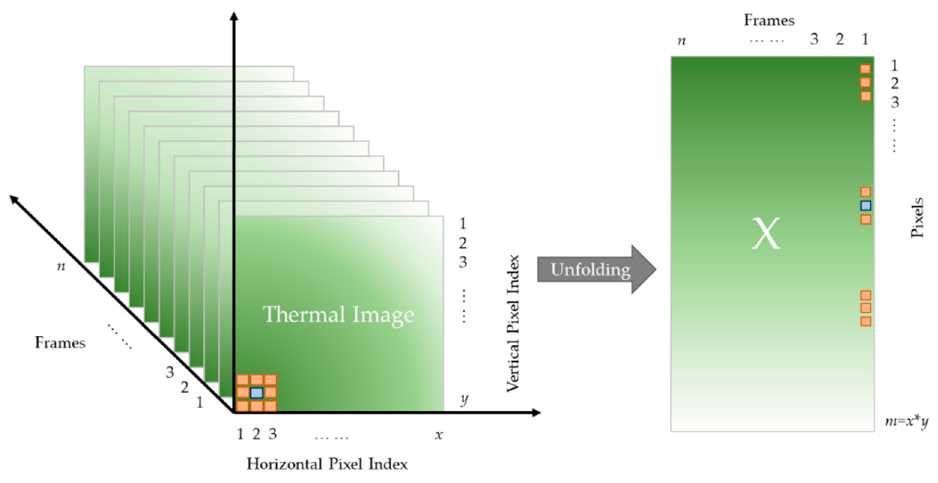
Figure 1. Structure of thermographic